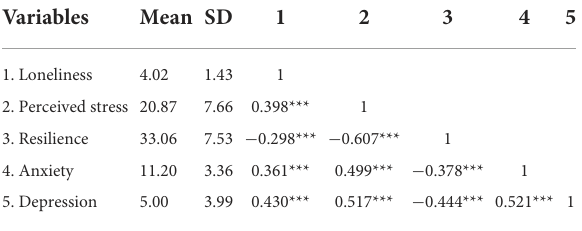
TABLE 2 Demographic characteristics of 654 participants. TABLE 3 The results of Pearson correlation analysis.